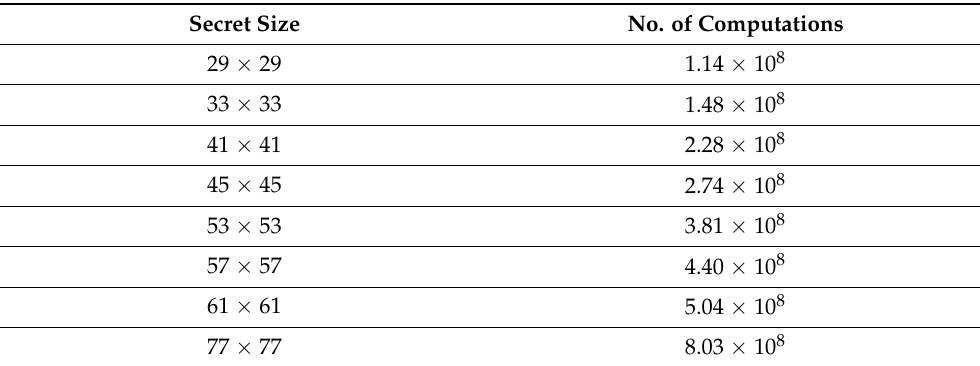
Table 8. No. of computations for LR to HR conversion.